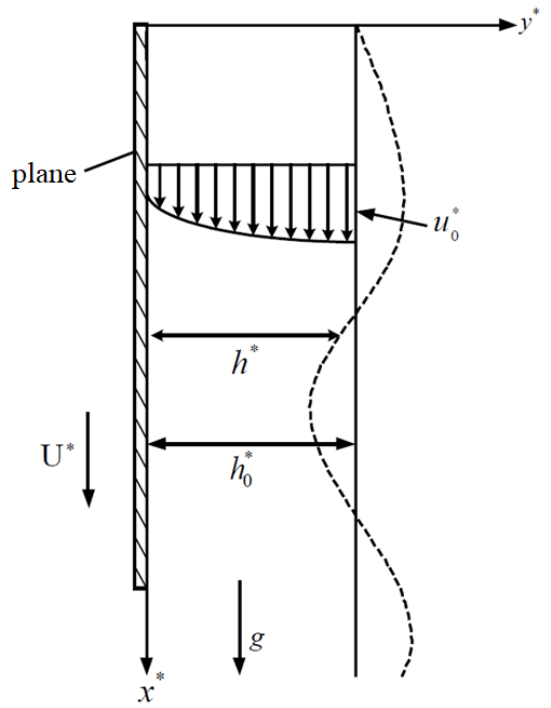
Figure 1. Schematic diagram of a thin power-law fluid film flowing down a moving plane in a vertical direction.